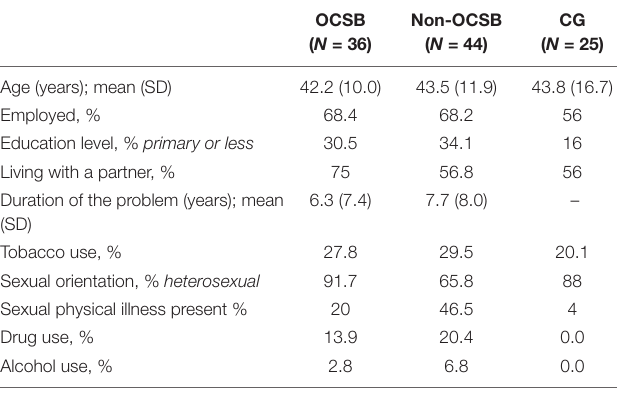
TABLE 1 | Socio-demographic variables of the experimental groups and control